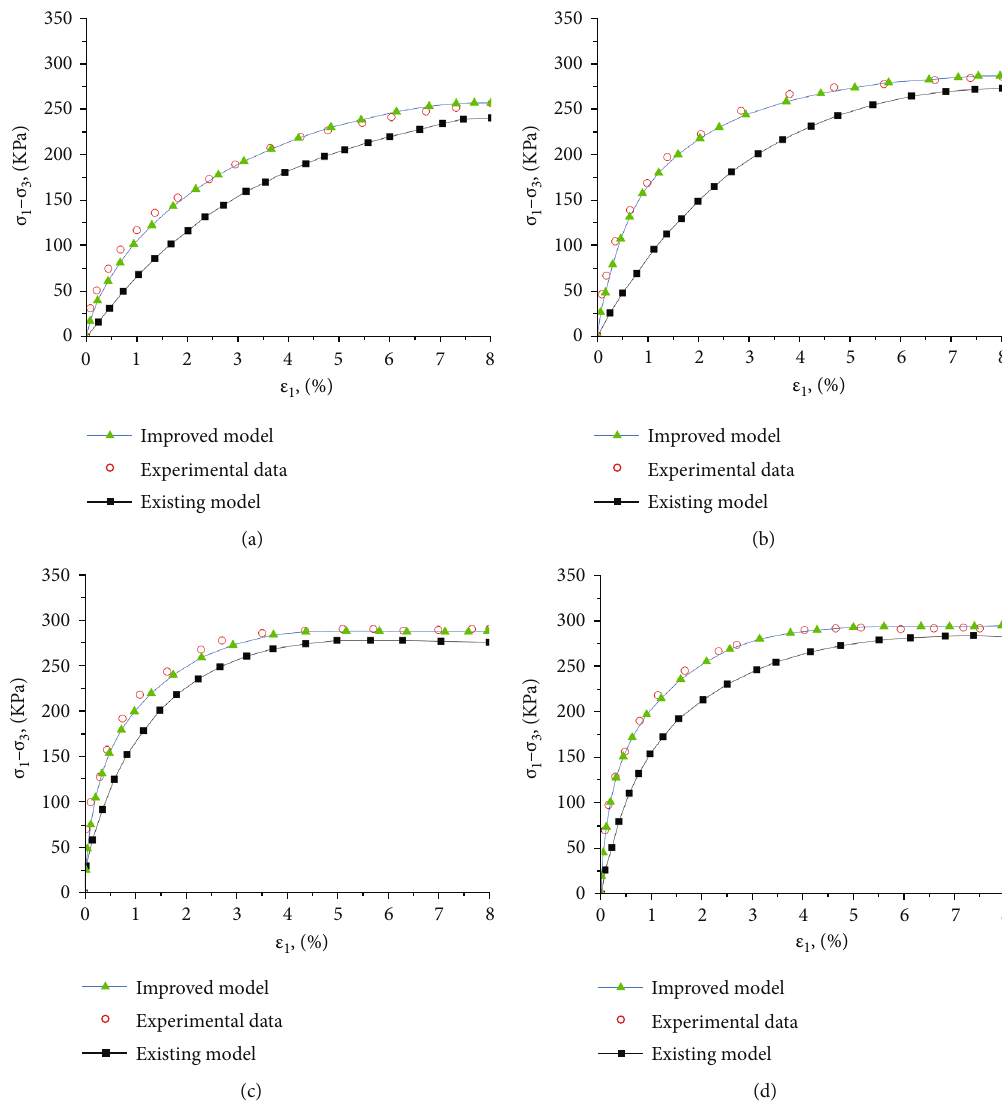
Figure 13: Comparison of two models with the experimental data by Oda [49]: (a) θ =0 ° ; (b) θ =30 ° ; (c) θ =60 ° ; (d) θ =90 °